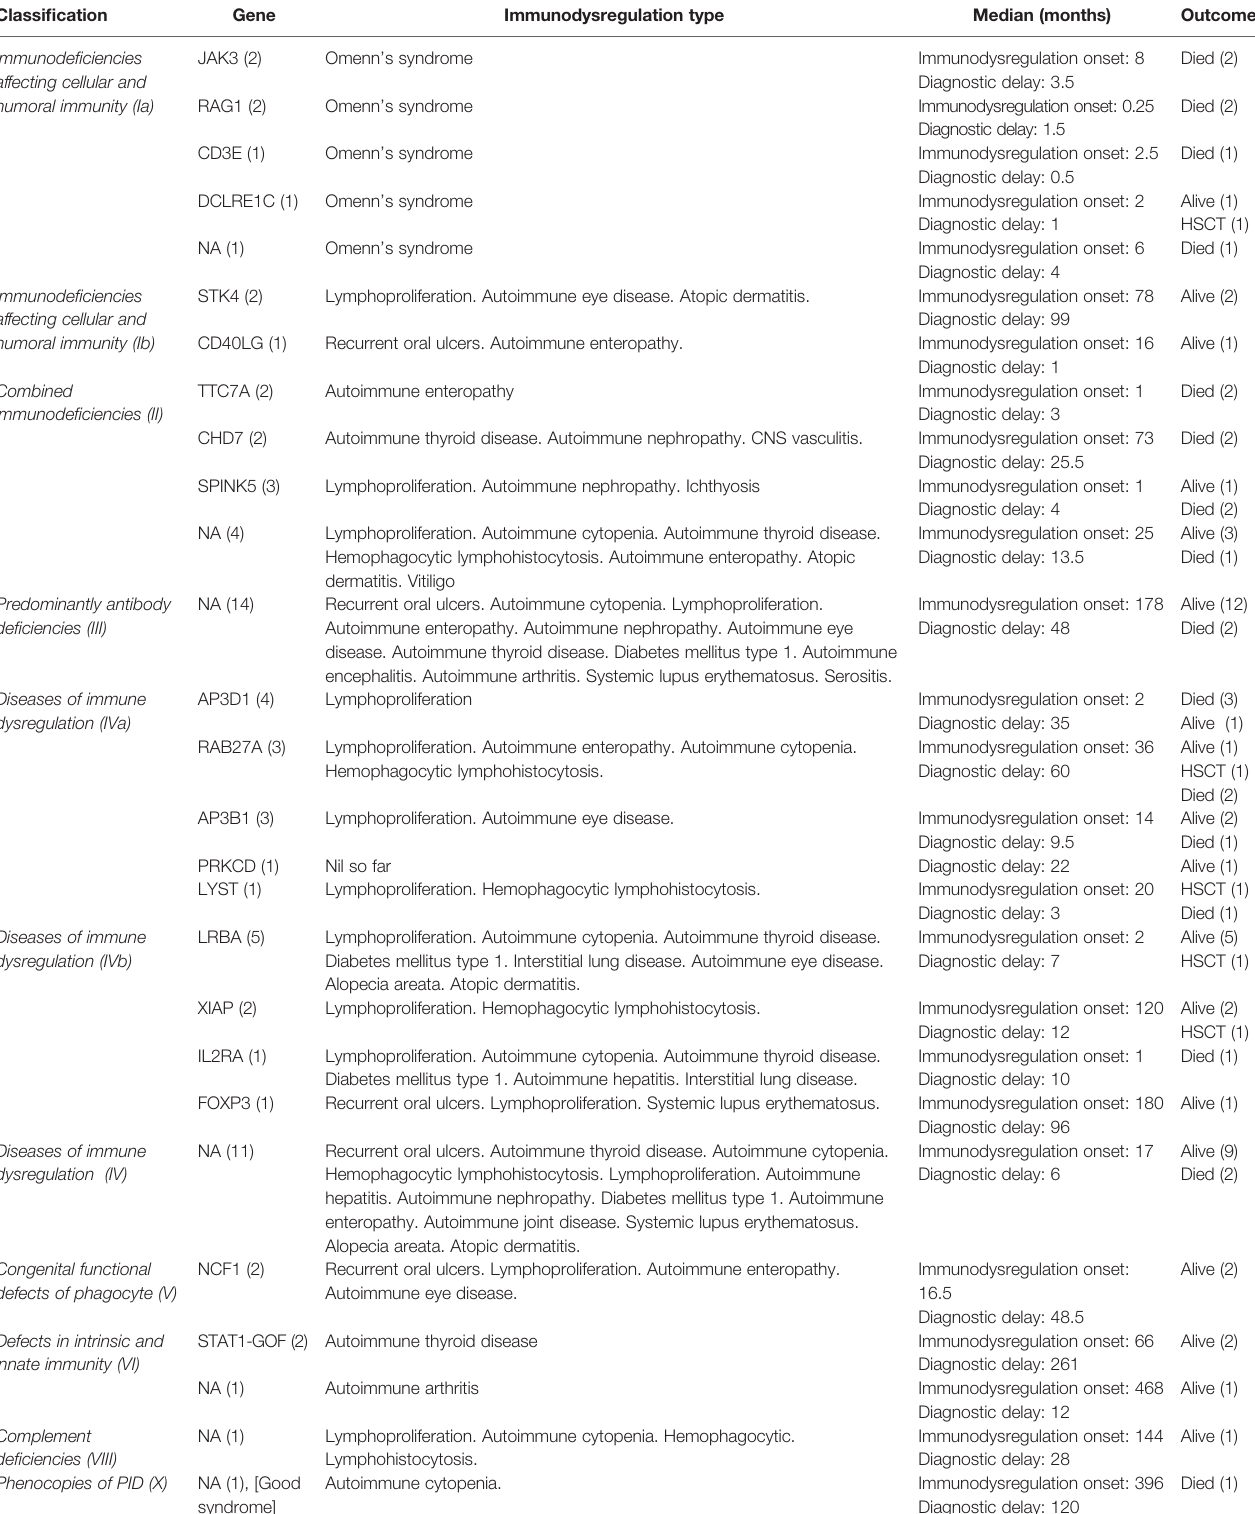
TABLE 3 | Summary describes the immunodysregulatory manifestations of patients with IEI according to IUIS category, genotype, phenotype, and